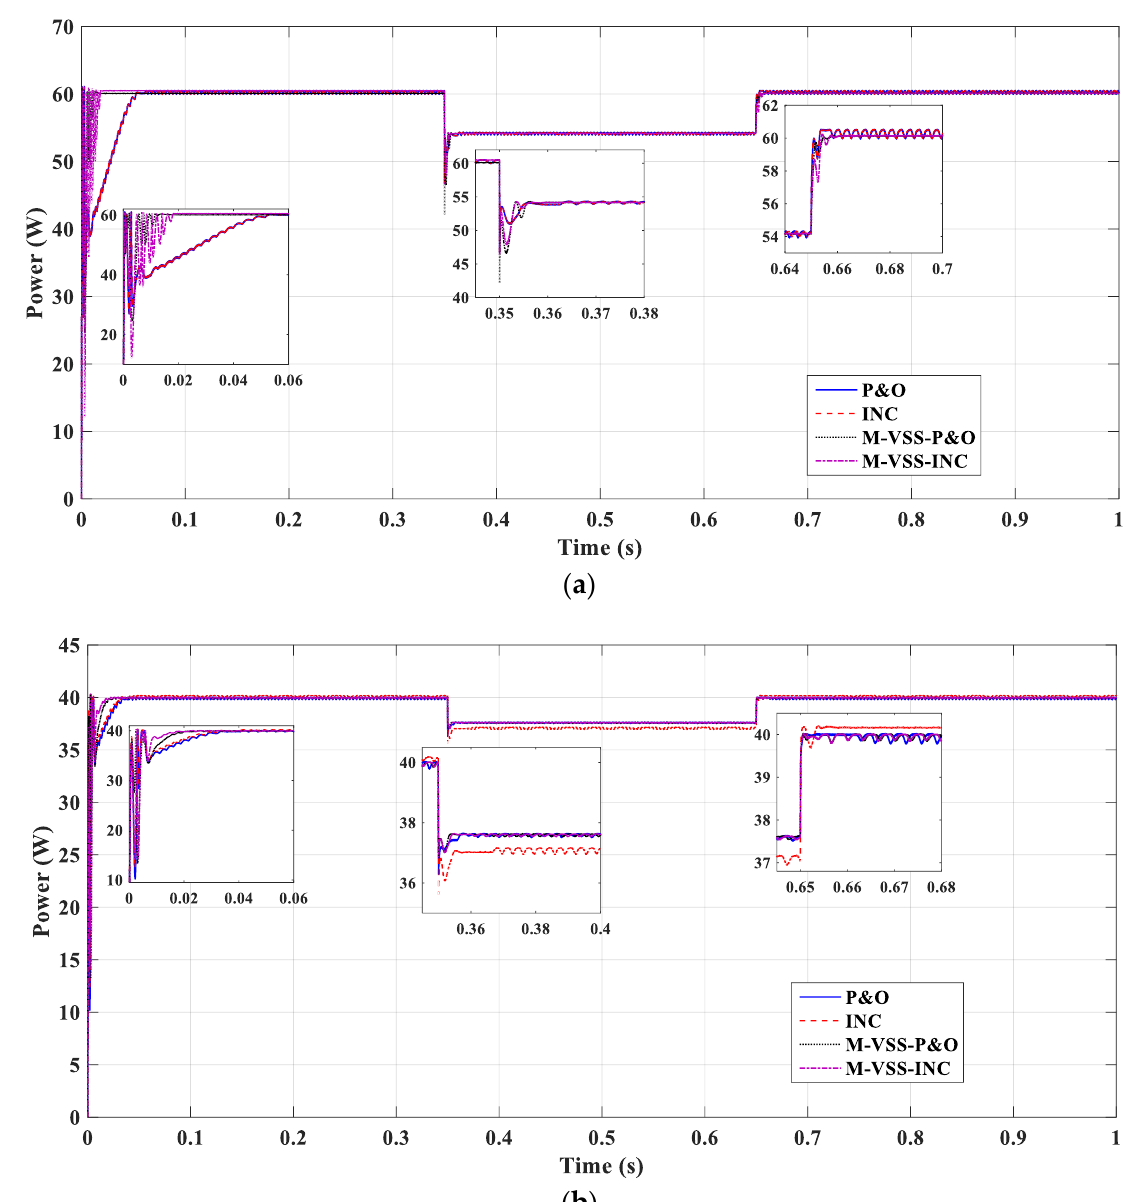
Figure 11. Cell performance under temperature sudden variation for ( a ) MSX60 and ( b ) ST40.